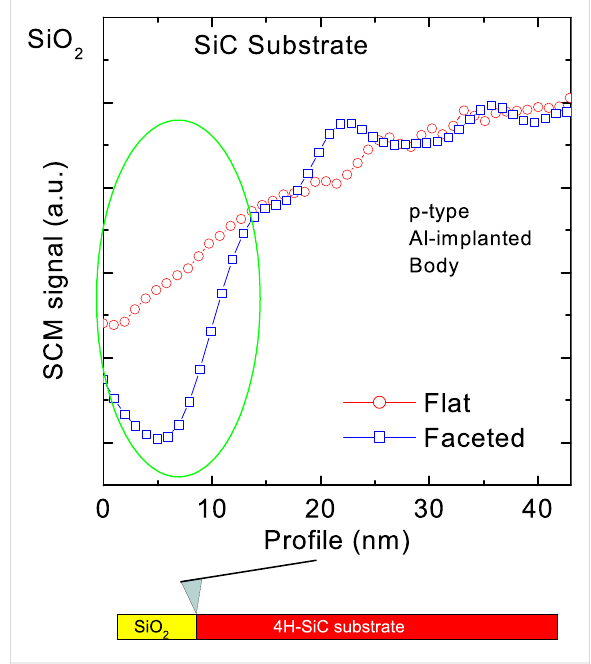
Figure 2: SCM profiling across the SiO 2 /4H-SiC interfaces on the faceted (blue squares) and flat (red circles) samples respectively.